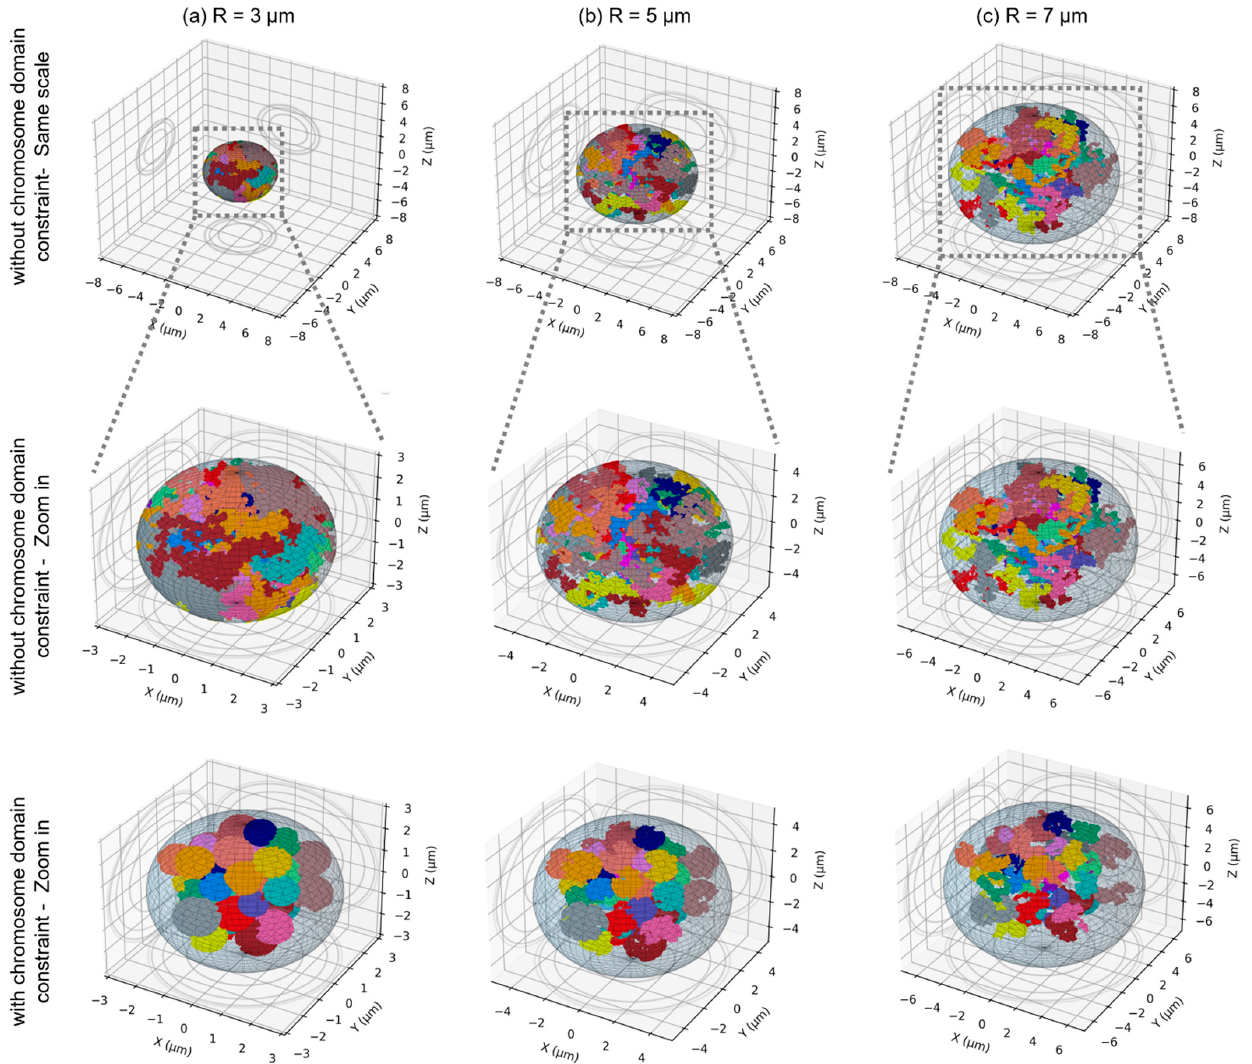
Figure 1. 3D distribution of the 46 chromosomes within spherical nuclei of different sizes: ( a ) R = 3 μ m, ( b ) R = 5 μ m and ( c ) R = 7 μ m. In the top row, the nuclei are represented at the same scale, and the chromosomes are not constrained within their domain. The same nuclei are displayed in the middle row with a magnification of each to visualize the different packing densities. In the bottom row, the chromosomes are constrained to be within their domain.